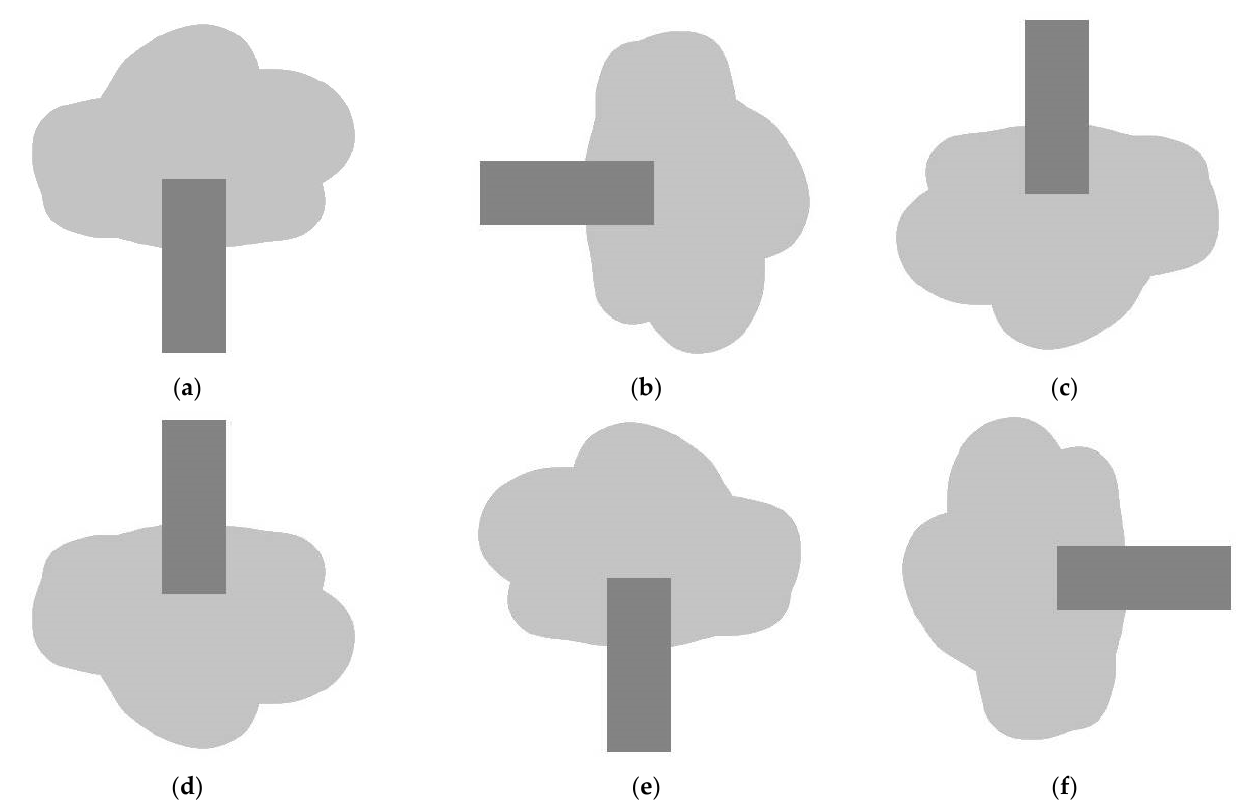
Figure 5. The schematic diagram of data enhancement. ( a ) Schematic diagram of an individual tree; ( b ) schematic diagram of 90° rotation; ( c ) schematic diagram of 180° rotation; ( d ) schematic diagram of 270° rotation; ( e ) schematic diagram of horizontal flipping; ( f ) schematic diagram of vertical flipping.